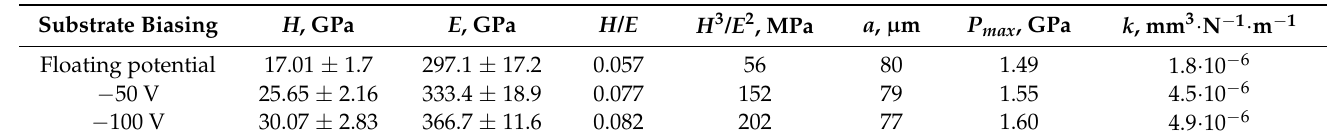
Table 2. Mechanical and tribological properties of the TiAlN coatings deposited by the Al magne- tron at 30 W of power.